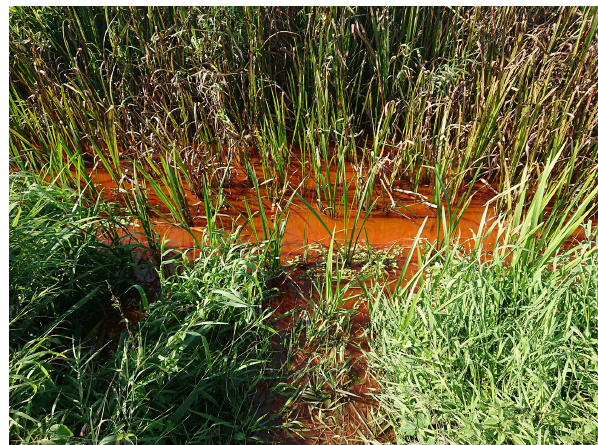
Figure 5. Sample photo showing complex vegetation in the Warsza- wicki Channel, taken during Exp